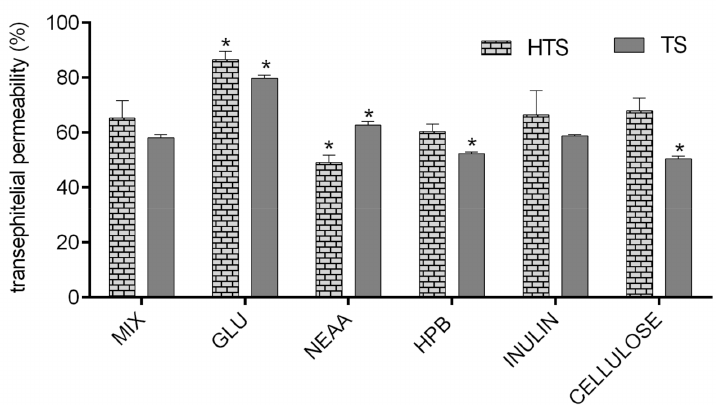
Figure 5. Permeability (%) of HTS and TS in Caco-2 cell monolayer (the amount of TS / HTS in basolateral compartment was expressed as the percentage of the amount applied to Caco-2 cell monolayer).